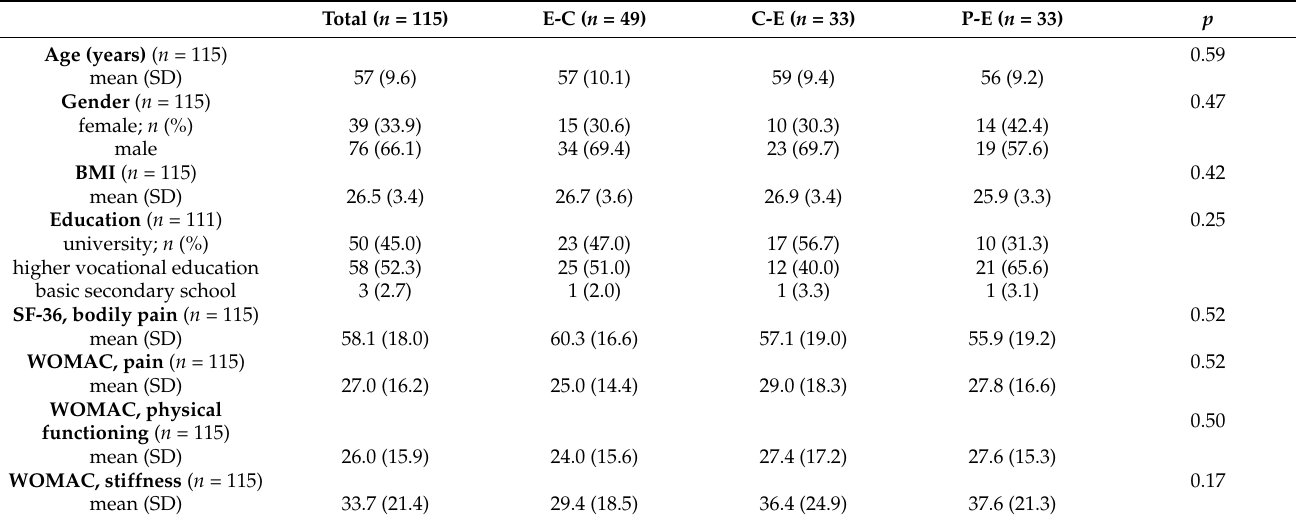
Table 1. Baseline characteristics of all finishers ( n =